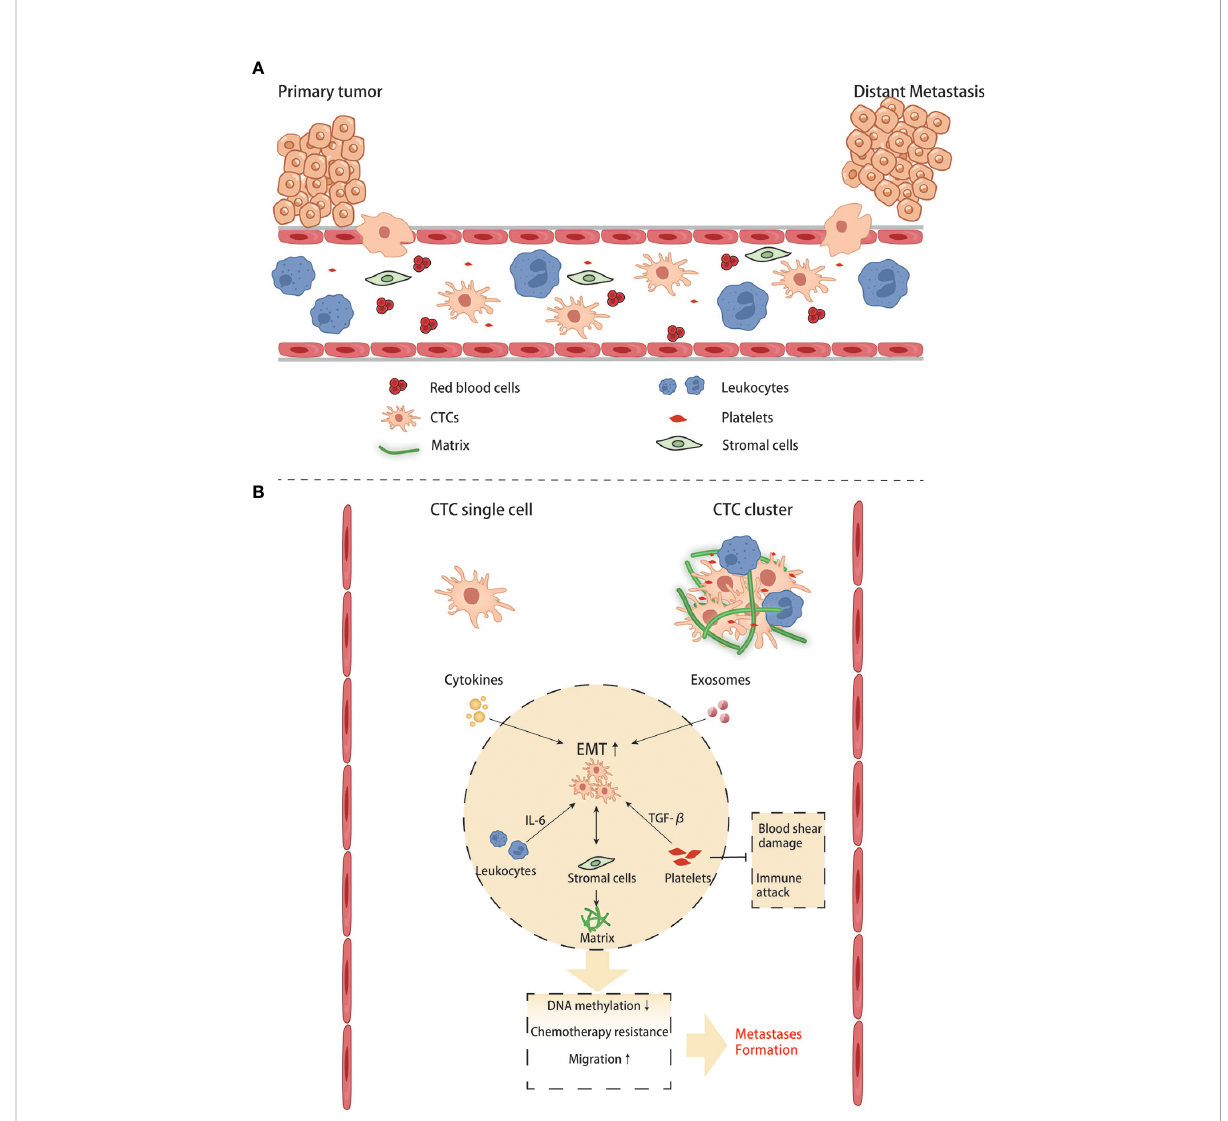
FIGURE 4 Crosstalk between CTCs and other blood components in the circulation. (A, B) CTC single cell and CTC clusters interact with blood cells and stromal